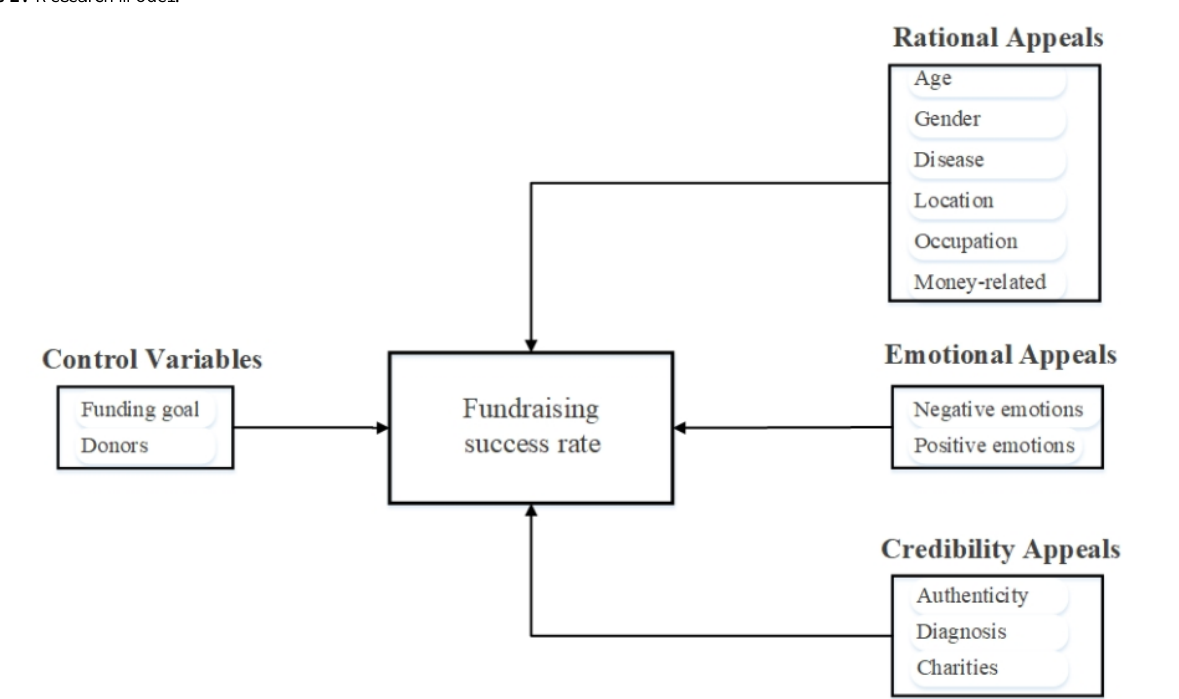
Figure 2. Research